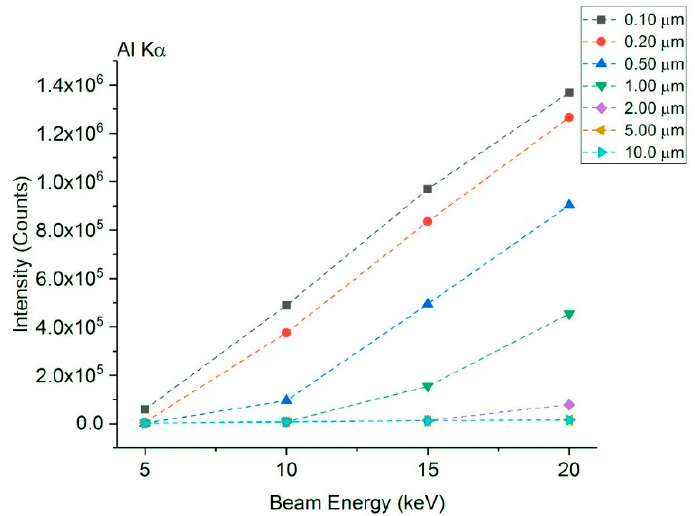
Figure 5. Simulation of the SEM-EDS X-ray intensity of the aluminum K α line as a function of both the electron beam energy and thickness of the prismatic shaped sample fragment. The statistical variation for each point is of the order of 1%.